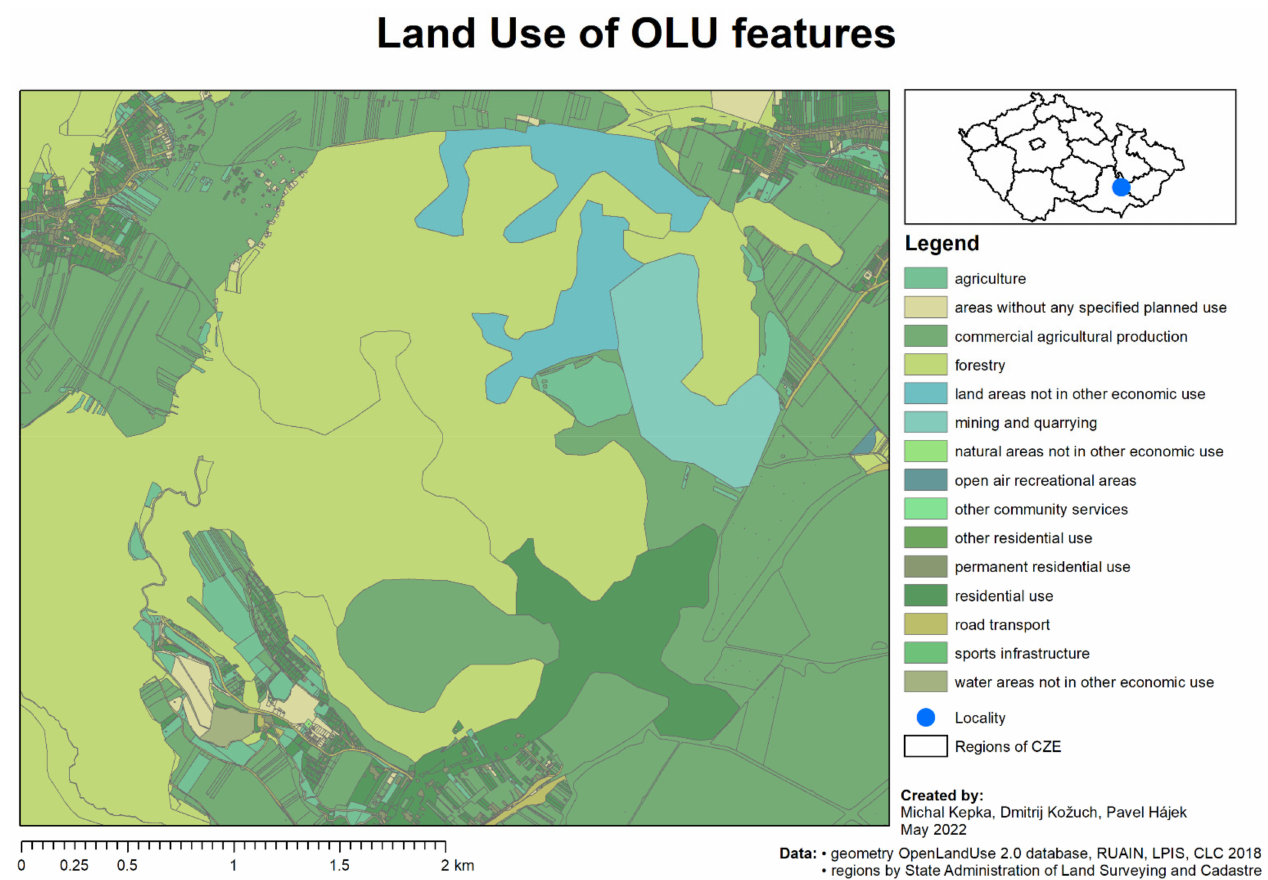
Figure 3. Example of a visualization of the land-use types on OLU reference